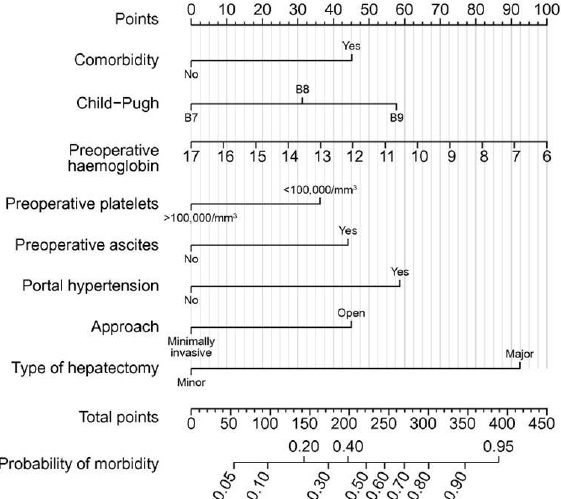
Figure 2. Nomogram for predicting 90-day morbidity after liver resection for hepatocellular carci- noma in patients with Child-Pugh class B. Nomogram was drawn using the multivariable logistic model for 90-day morbidity. Reprinted/adapted with permission from Ref. [70]. 2019, Elsevier.